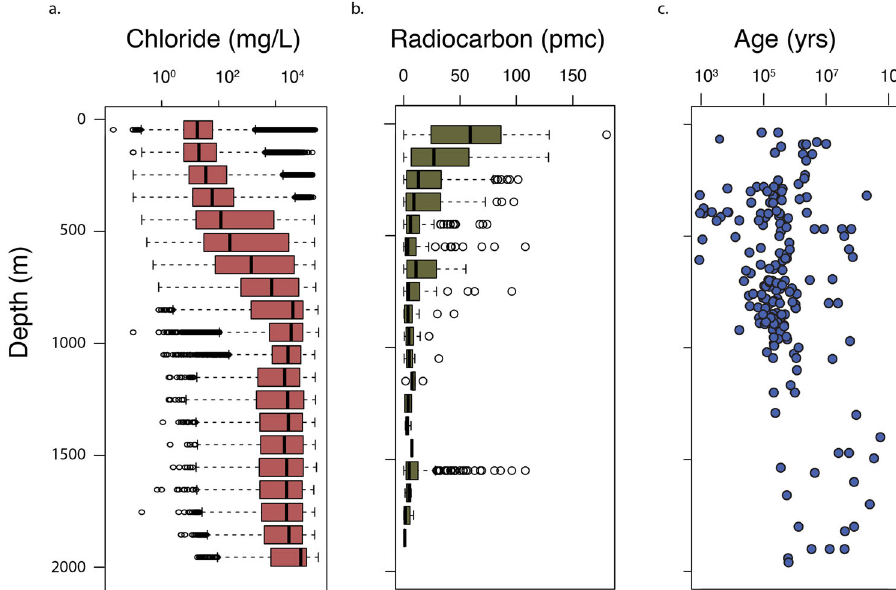
Fig. 1 Groundwater Cl and age typically increase with depth. This is shown by the distribution of a chloride (mg/L), b radiocarbon (percent modern carbon (pmc)) and c groundwater age with depth from noble gas measurements. Cl concentrations are derived from the USGS NAWQA Database 93 and USGS National Produced Waters Geochemical Database 61 . Percent modern carbon data was compiled by Jasechko et al. (2017). Residence time estimates are compiled from a range of sources (Supplementary Data 1). Boxes extend to 25 th and 75 th percentiles and whiskers represent the extreme values or ±1.5 times the interquartile